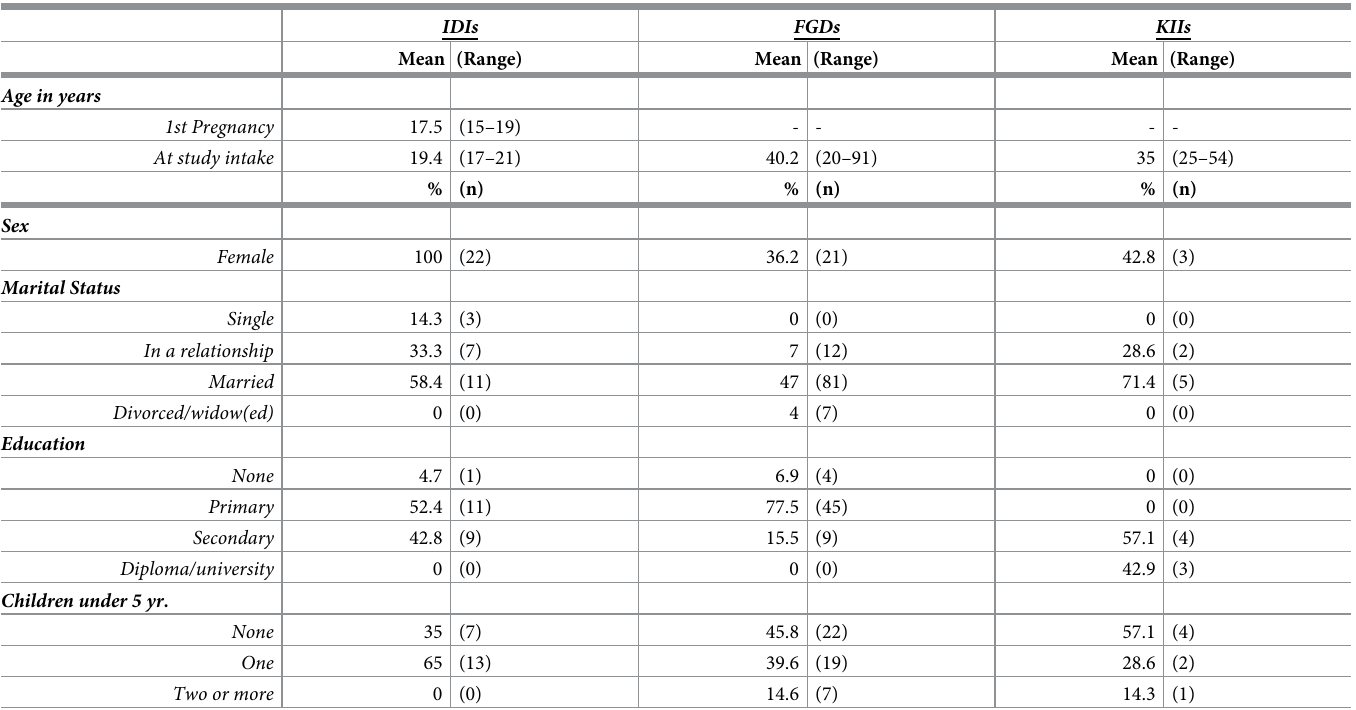
Table 1. Participant